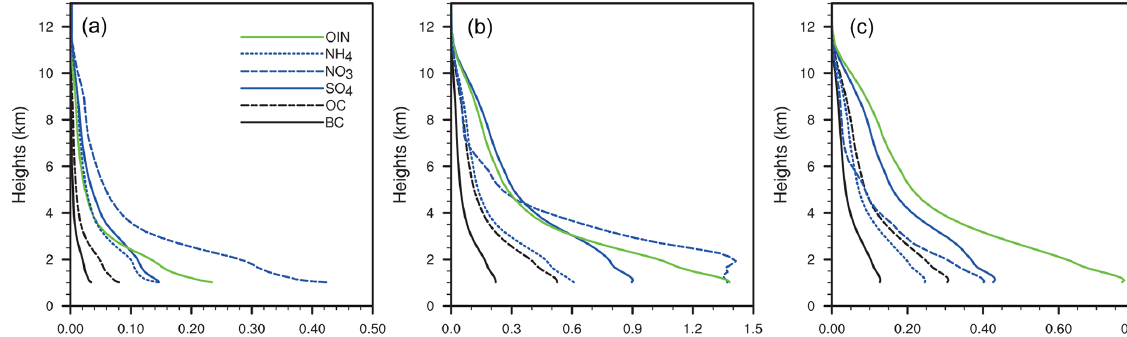
Figure 1. Domain-averaged standard deviations of the background errors (µgkg − 1 ) as a function of the height for each aerosol variable in three bins: (a) Bin 1 – 0.039–0.1µm, (b) Bin 2 – 0.1–1.0µm, and (c) B in 3 – 1.0–2.5µm. Table 1. WRF/Chem model configuration. Aerosol scheme MOSAIC (four bins; Zaveri et al., 2008) Photolysis scheme Fast-J (Wild et al.,